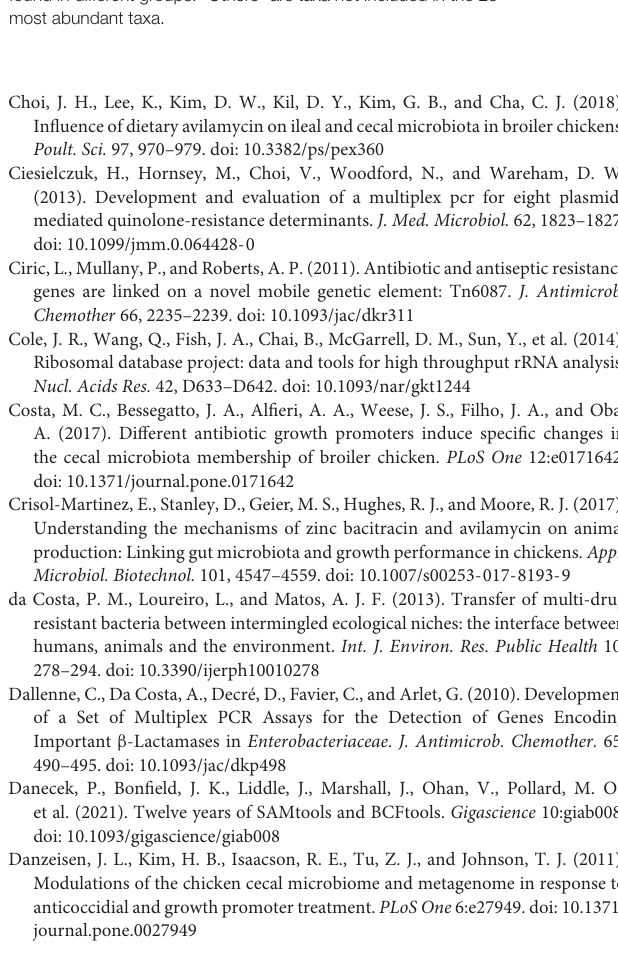
Supplementary Table 4 | Statistical analysis of alpha diversity measures for comparing different groups. Supplementary Table 5 | List of antimicrobial resistance genes detected in shotgun sequencing data. Supplementary Table 6 | Effects of different antimicrobial growth promoters (AGPs) on the prevalence of antimicrobial resistance genes (ARGs) as determined by conventional PCR and